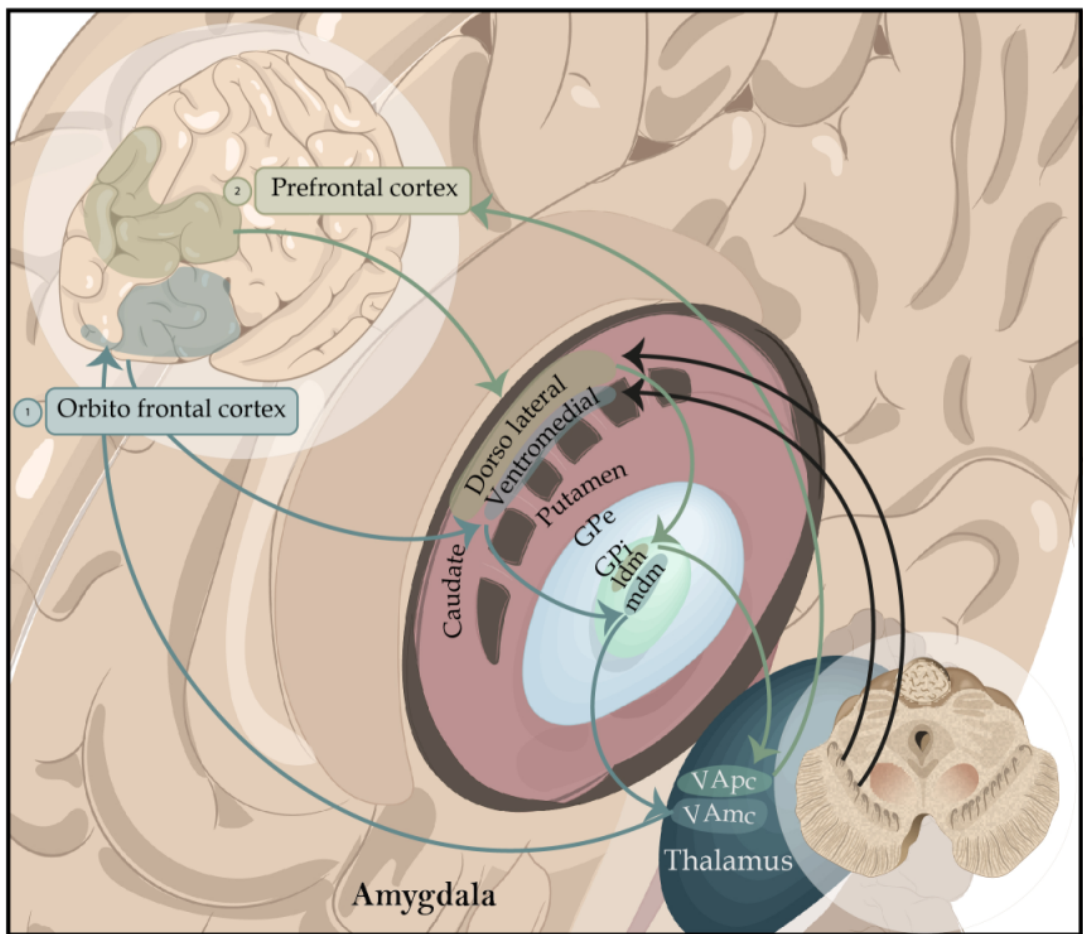
Figure 3. Representation of the basal ganglia focused on cognitive functions. Ventrolateral circuit. 1. It begins in the ventrolateral frontal cortex, which is the first node of interaction with the posterior regions. It’s in charge of low-level control processes and involved in stimulus-driven recall and information retrieval from long-term memory. Lateral mediodorsal circuit. 2. It begins in the mediolateral cortex of the frontal cortex. It’s in charge of high-level executive processes and involved in the manipulation and monitoring of care and is in charge of creating organizational strategies. Abbre-